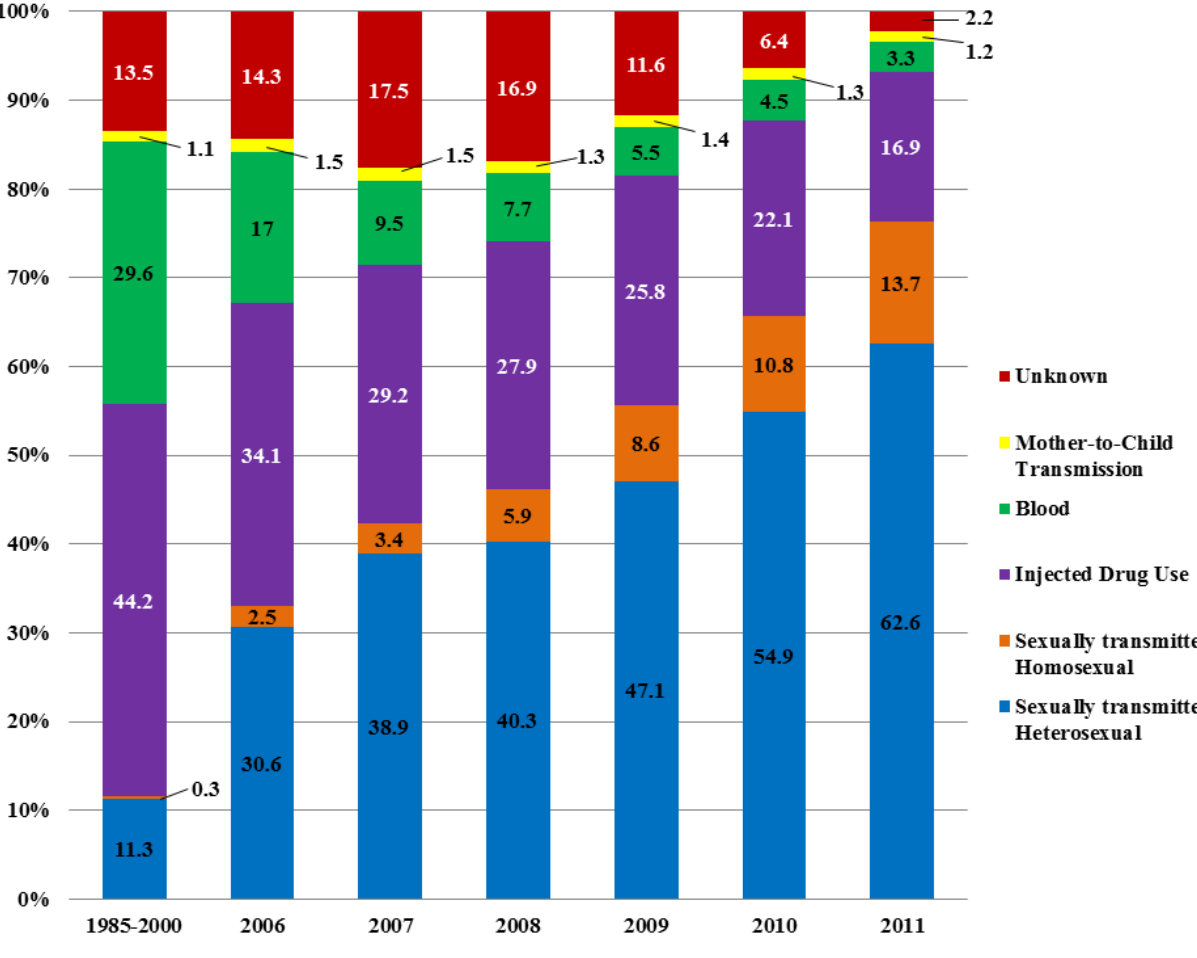
Figure 1. Composition of newly reported HIV infections. Adapted from